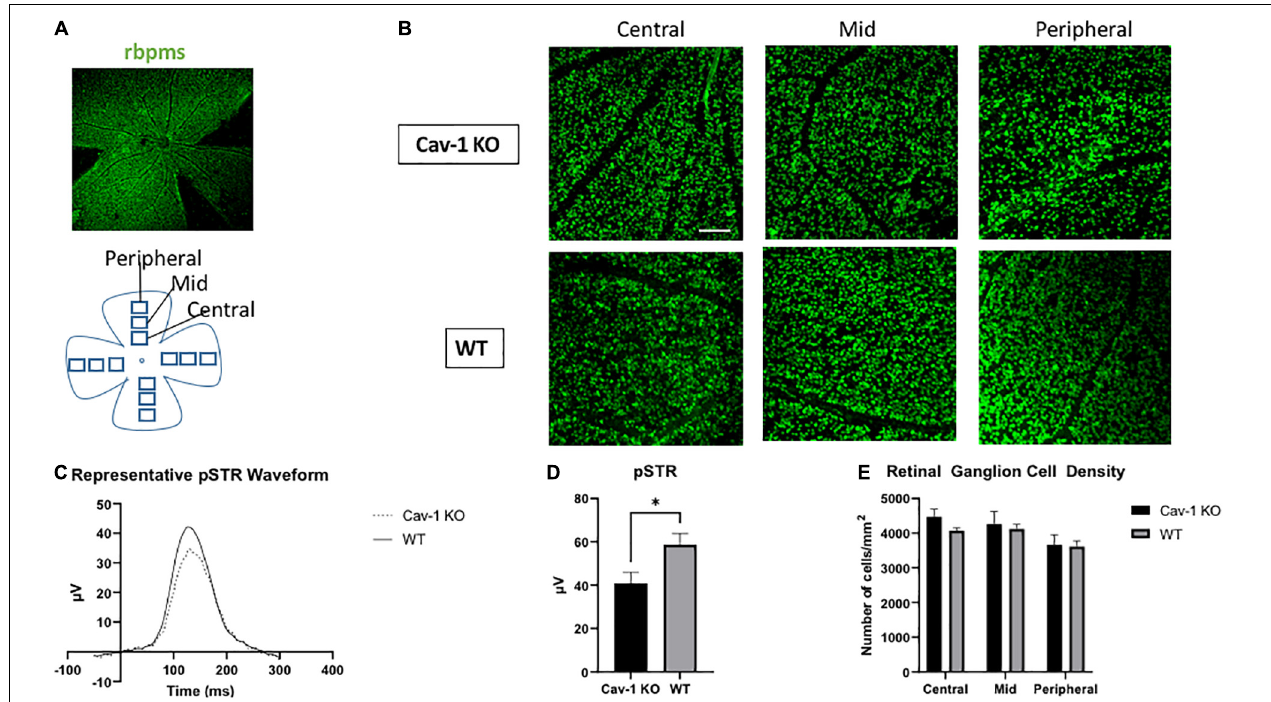
FIGURE 5 | Retinal ganglion cell function and density. (A) Representative image of flat-mounted retina stained with retinal ganglion cell marker rbpms (green). (B) Rbpms staining at various eccentricities from the optic nerve head in flatmounted retina, scale bar in white indicates 100 µ m. (C) Representative pSTR waveform in Cav-1 KO and WT mice. (D) Cav-1 KO mice show reduced pSTR compared to WT. (E) Mean retinal ganglion cell density is not significantly different in Cav-KO and WT mice, * p <